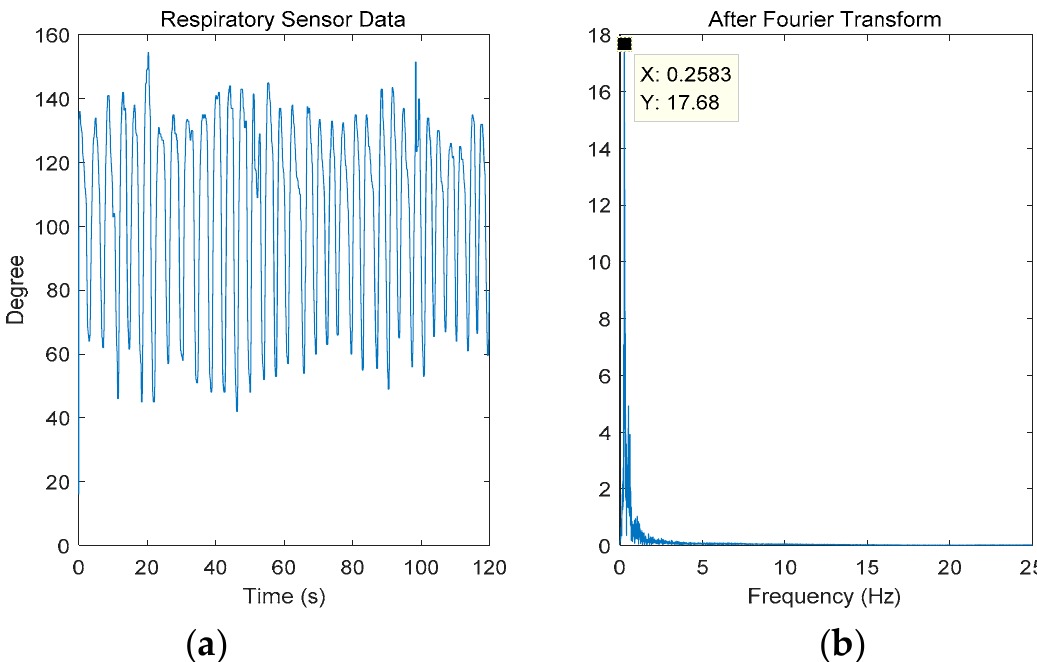
Figure 5. The respiratory signal measured by the respiratory sensor when laying down: ( a ) the time domain signal and ( b ) the frequency domain signal after Fourier transform.